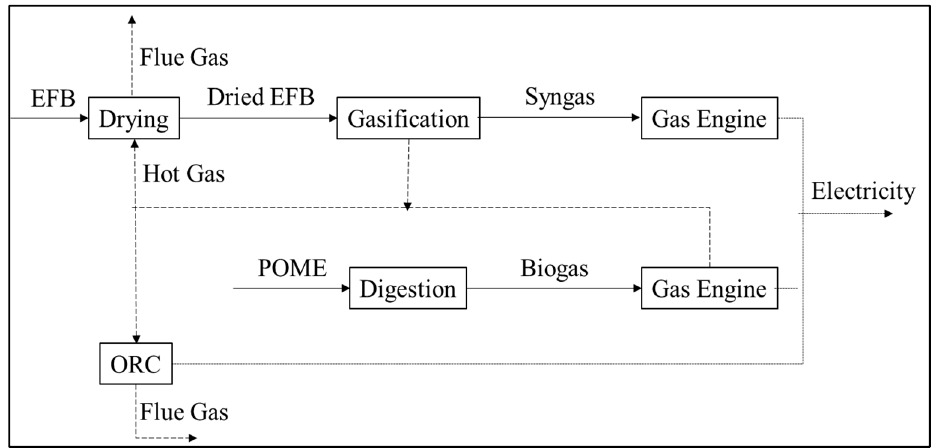
Figure 10. Conceptual diagram of a small-scale integrated power plant for EFB and POME. Adapted with permission from ref. [57]. Copyright 2017 Elsevier.